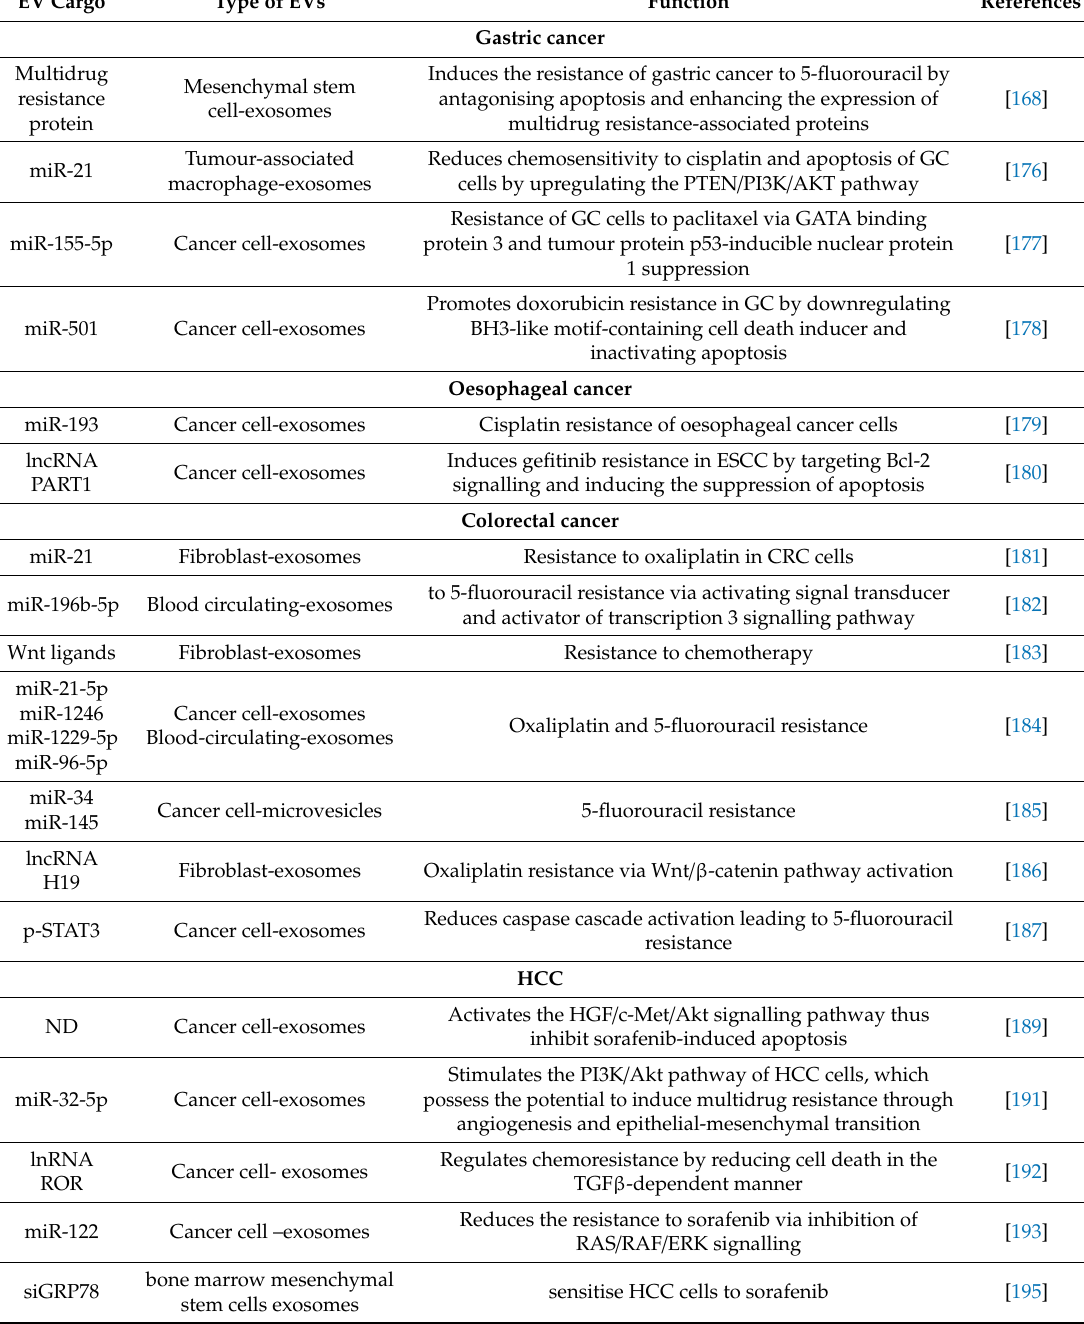
Table 2. Summary of functions of small and large EVs and their identified major component contributing to the response to a systemic